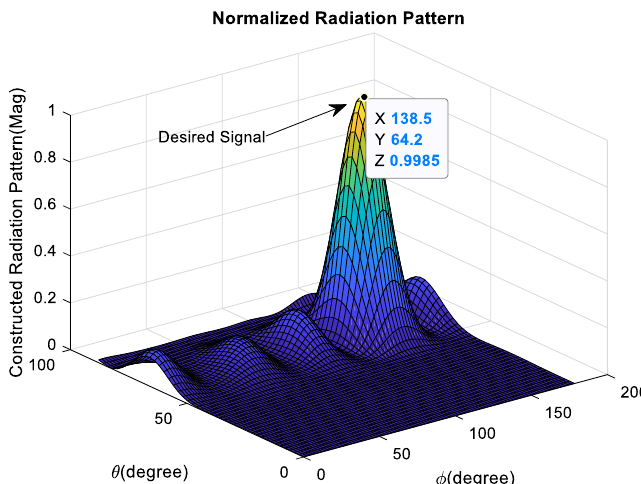
Fig. 9 Normalized radiation pattern of beamforming in presence of three far-field scatterers (linear scale)